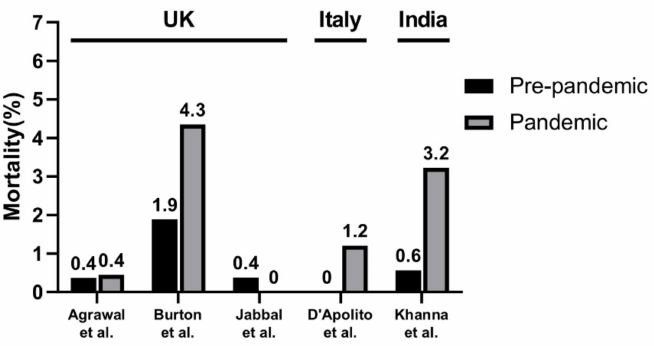
Figure 5. Visualization of overall mortality in included